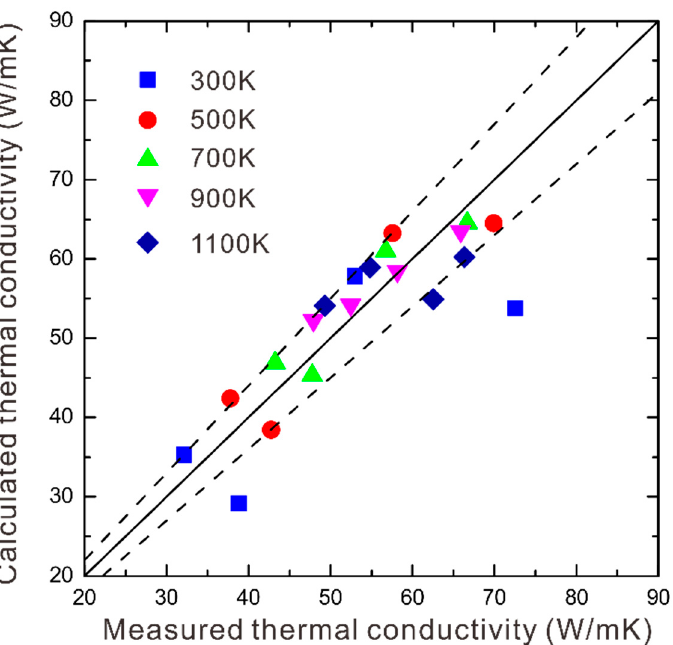
Figure 8. The comparison between the thermal conductivities evaluated via this developed model and the LFA-measured ones. and the LFA-measured